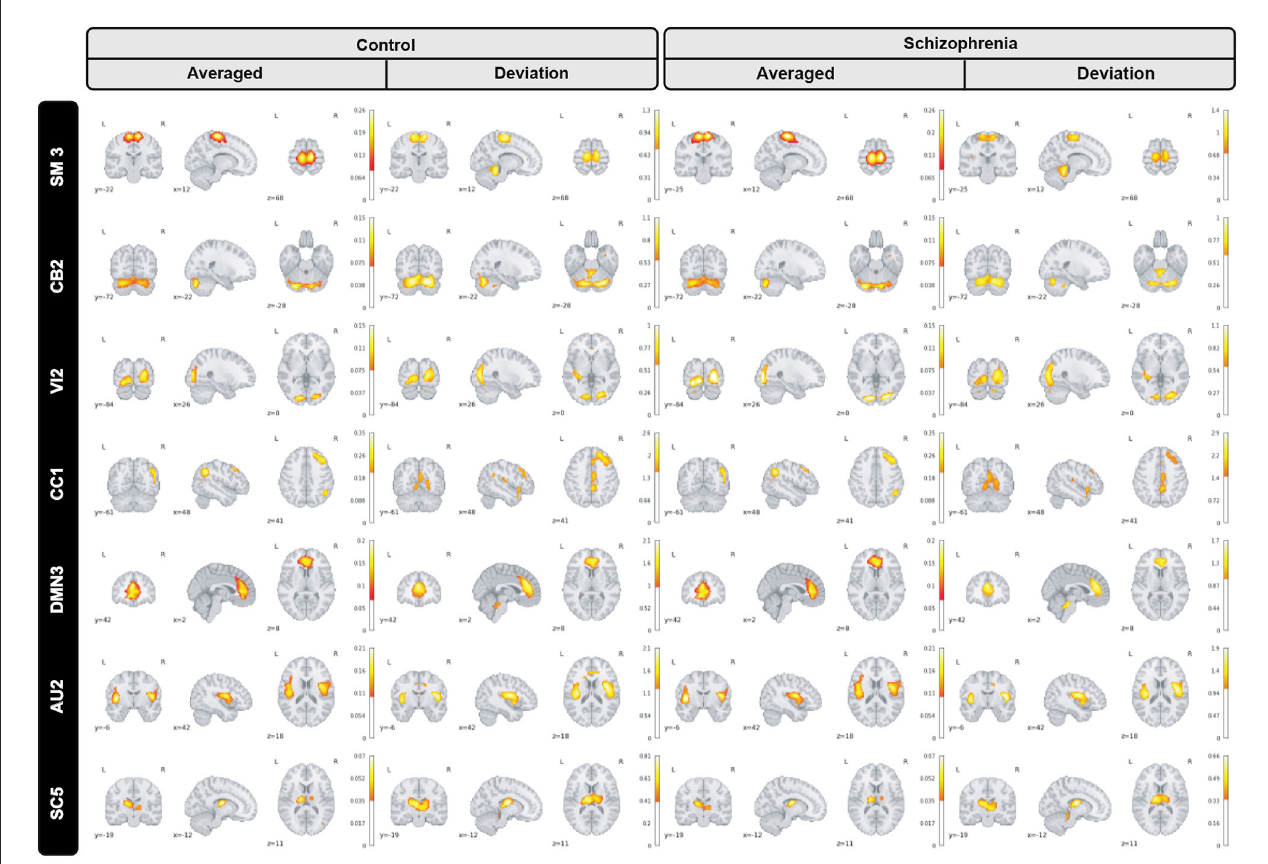
FIGURE6 Group level spatial dynamics which change over time, averaged over subjects for the control schizophrenia in sensori-motor (SM3), cerebellar (CB2), visual (VI2), cognitive control (CC1), default mode network (DMN3), auditory (AU2), and subcortical (SC5) networks. All brain maps are thresholded to highlight functional changes which are not visible in the averaged